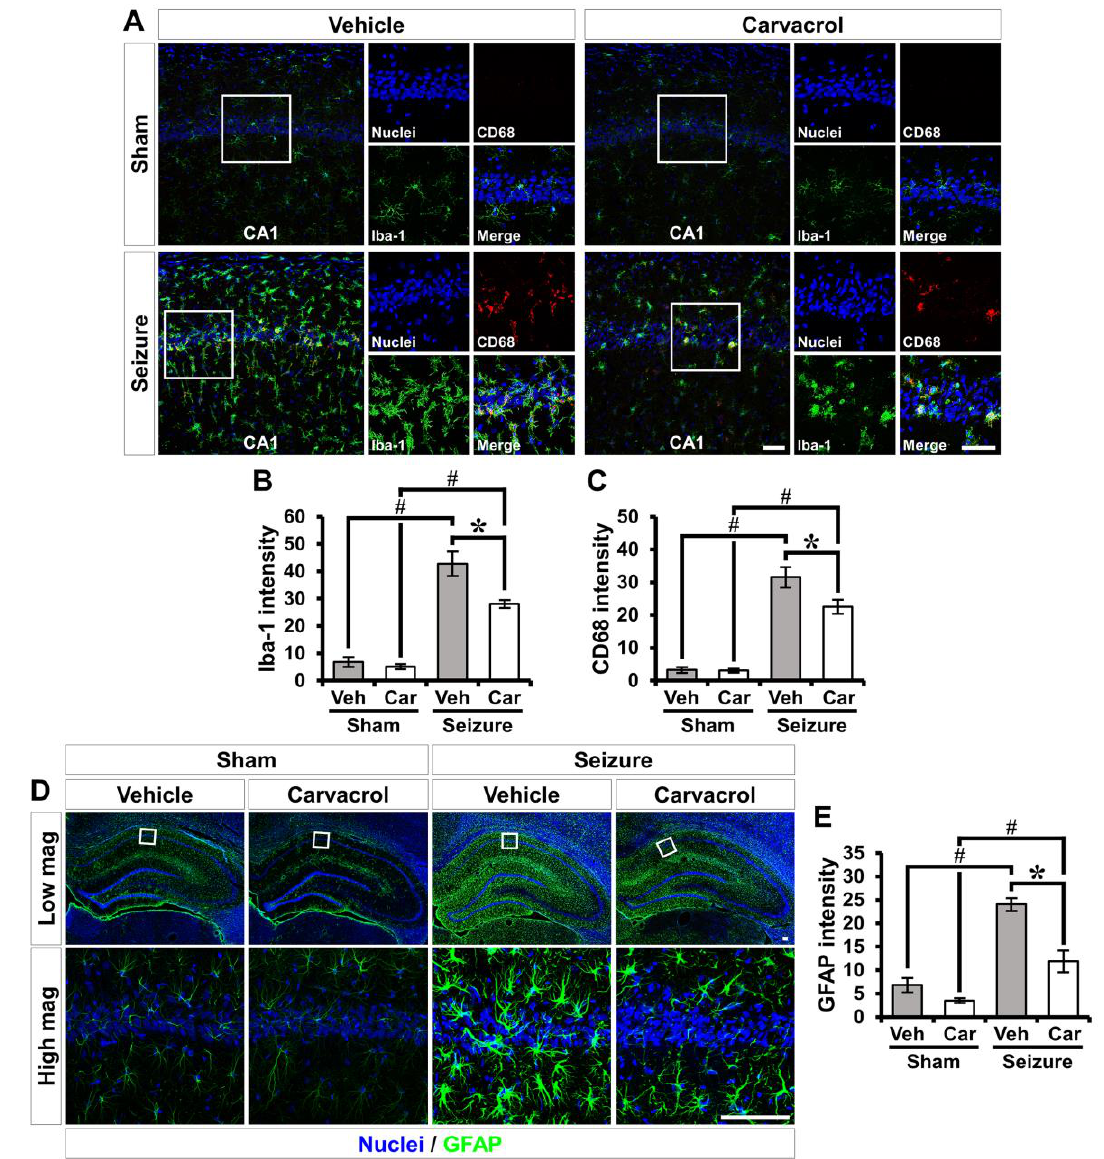
Figure 4. Carvacrol treatment reduces seizure-induced glial activation. ( A ) Double-label confocal micrographs of Iba-1 (green) and CD68 (red) in the hippocampal CA1 from the vehicle- and carvacrol-treated groups after sham or SE. Nuclei stained with DAPI (blue). Scale bar, 50 µ m. ( B , C ) Bar graphs showing the intensity of Iba-1 ( B ) and CD68 ( C ) as determined in the same hippocampal region (mean ± SEM; n = 5 from each sham group, n = 6–8 from each seizure group). * p < 0.05 vs. the vehicle-treated group; # p < 0.05 vs. the sham-operated group (Kruskal–Wallis test followed by a Bonferroni post-hoc test; Figure 4B: chi square = 19.244, df = 3, p < 0.001; Figure 4C: chi square = 18.708, df = 3, p < 0.001). ( D ) Immunofluorescent images representing the astrocyte activation stained for anti-GFAP (green) in the hippocampus. Nuclei are counterstained with DAPI (blue). Scale bar = 100 µ m. ( E ) Quantification of the immunofluorescence intensity of GFAP as determined in the same hippocampal region (mean ± SEM; n = 4–5 from each sham group, n = 7 from each seizure group). * p < 0.05 vs. the vehicle-treated group; # p < 0.05 vs. the sham-operated group (Kruskal–Wallis test followed by a Bonferroni post-hoc test: chi square = 16.32, df = 3, p = 0.001).